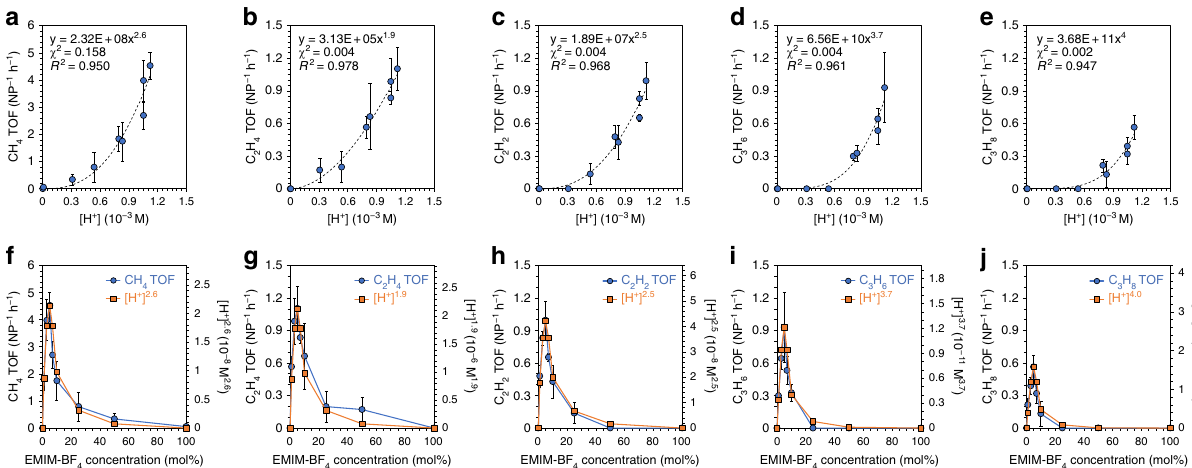
Fig. 4 Empirical kinetic model for the CO 2 RR. a – e For each of the hydrocarbon products, the TOF is plotted as a function of the H + concentration, [H + ], which serves as a proxy for the concentration of the [EMIM*-CO 2 ] complex. A fi t to a power-law function y = ax n (dashed line) yields the fi t parameter n , which represents the apparent reaction order in [H + ]. The best- fi t equation is indicated for each plot along with the values of χ 2 and R 2 , which serve as metrics of the goodness-of- fi t. f – j For each hydrocarbon product, the TOF plotted as a function of the EMIM-BF 4 concentration follows a similar trend as the [H + ] n , where n is the corresponding reaction order obtained from the plots in a – e . Each data point in a – j is the average of results from three identical trials and the error bar represents the SD of these substrates and stabilization of high-energy charged intermediates is desirable. Data availability All raw images and source data are available from the authors upon reasonable request.